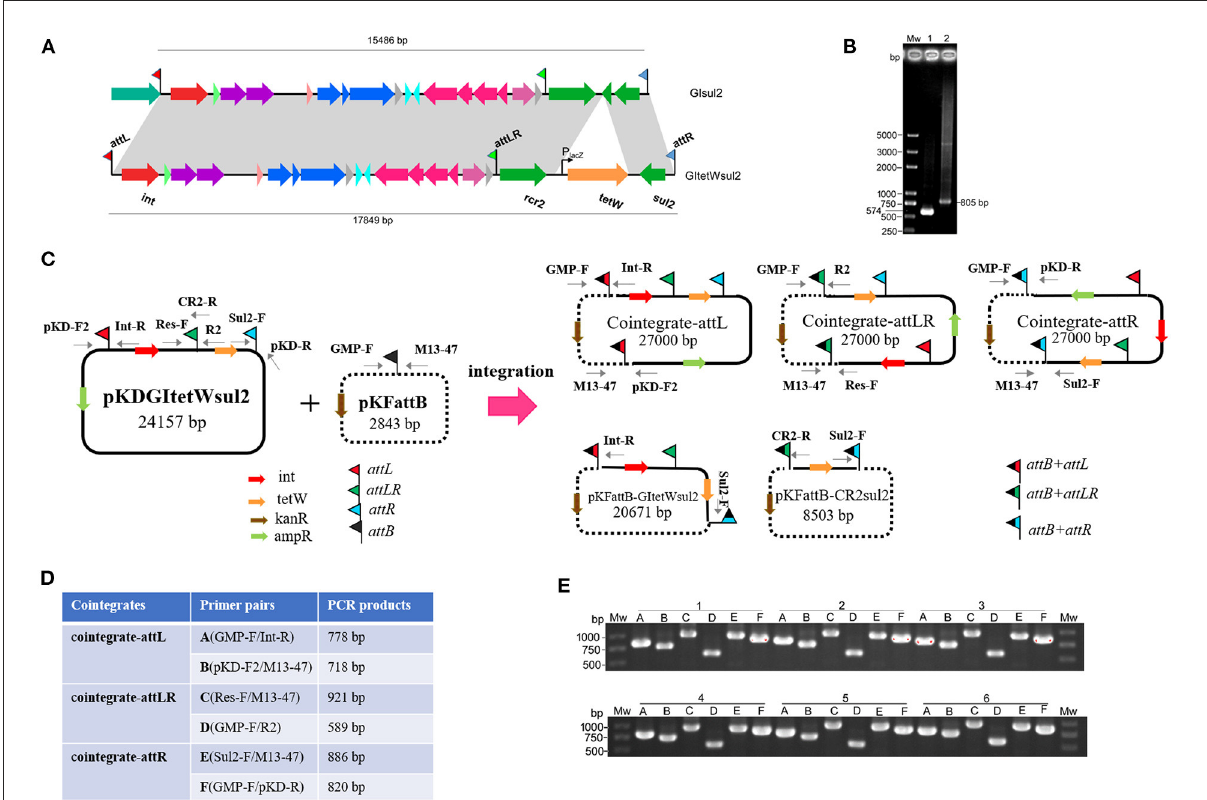
FIGURE3 Co-integrate formation in E. coli DH5 α through site-specific recombination at the att sites. (A) Construction of GI tetWsul2 . The gray shadings denote 100% identity between GI tetWsul2 and the original GI sul2 . ORFs (horizontal arrows) are colored as in Figure 1. (B) Detection of circular intermediates excised from the donor plasmid pKDGItetWsul2 in E. coli DH5 α . Mw, DNA size marker; lane 1, CR2 -sul2 unit circular intermediate; lane 2, GI tetWsul2 circular intermediate. (C) Organization of the donor (pKDGItetWsul2) and trap (pFKattB) plasmids used in the two-plasmid integration experiment, and expected recombinant structures. Intervening ORFs are depicted with filled arrows while red, green, blue, and black flags denote attL , attLR , attR, and attB , respectively. The putative hybrid attachment sites resulting from site-specific recombination are represented by two-color flags. Primers used for the detection of the various structures are indicated. (D) Couples of primer pairs used to detect co-integrate structures in recombinant bacteria, and their expected amplification size. (E) PCR amplification using the six primer pairs from (D) on the plasmid extracts of six independent recombinant colonies. Colonies are labeled 1–6, with the six primer pairs amplification (A–E) displayed below each of them.